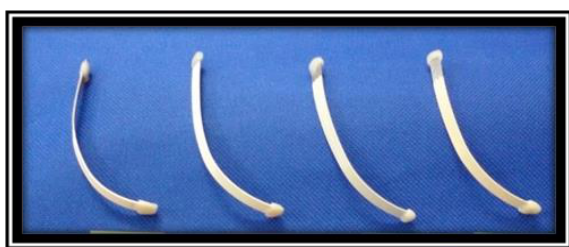
Fig. 2: Sample from each Company